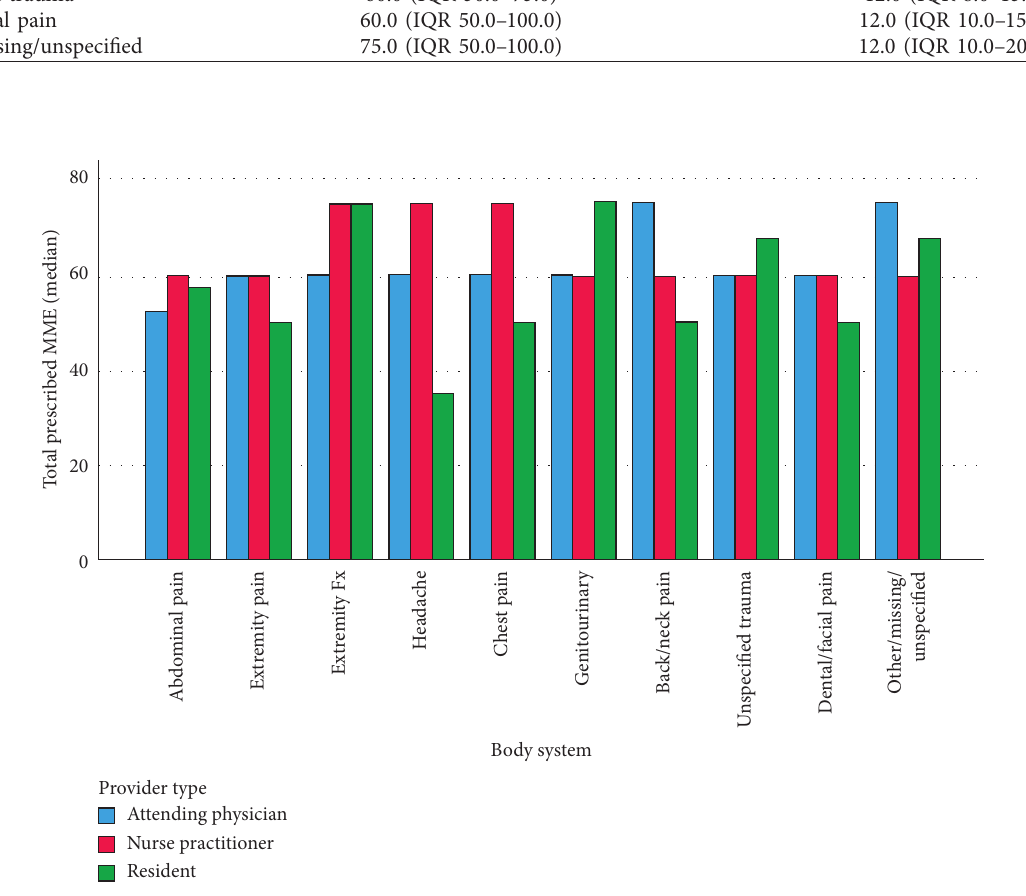
Figure 2: Subgroup analysis-total MME. This subgroup analysis depicts how each provider type (attending physician, nurse practitioner, and resident physician)